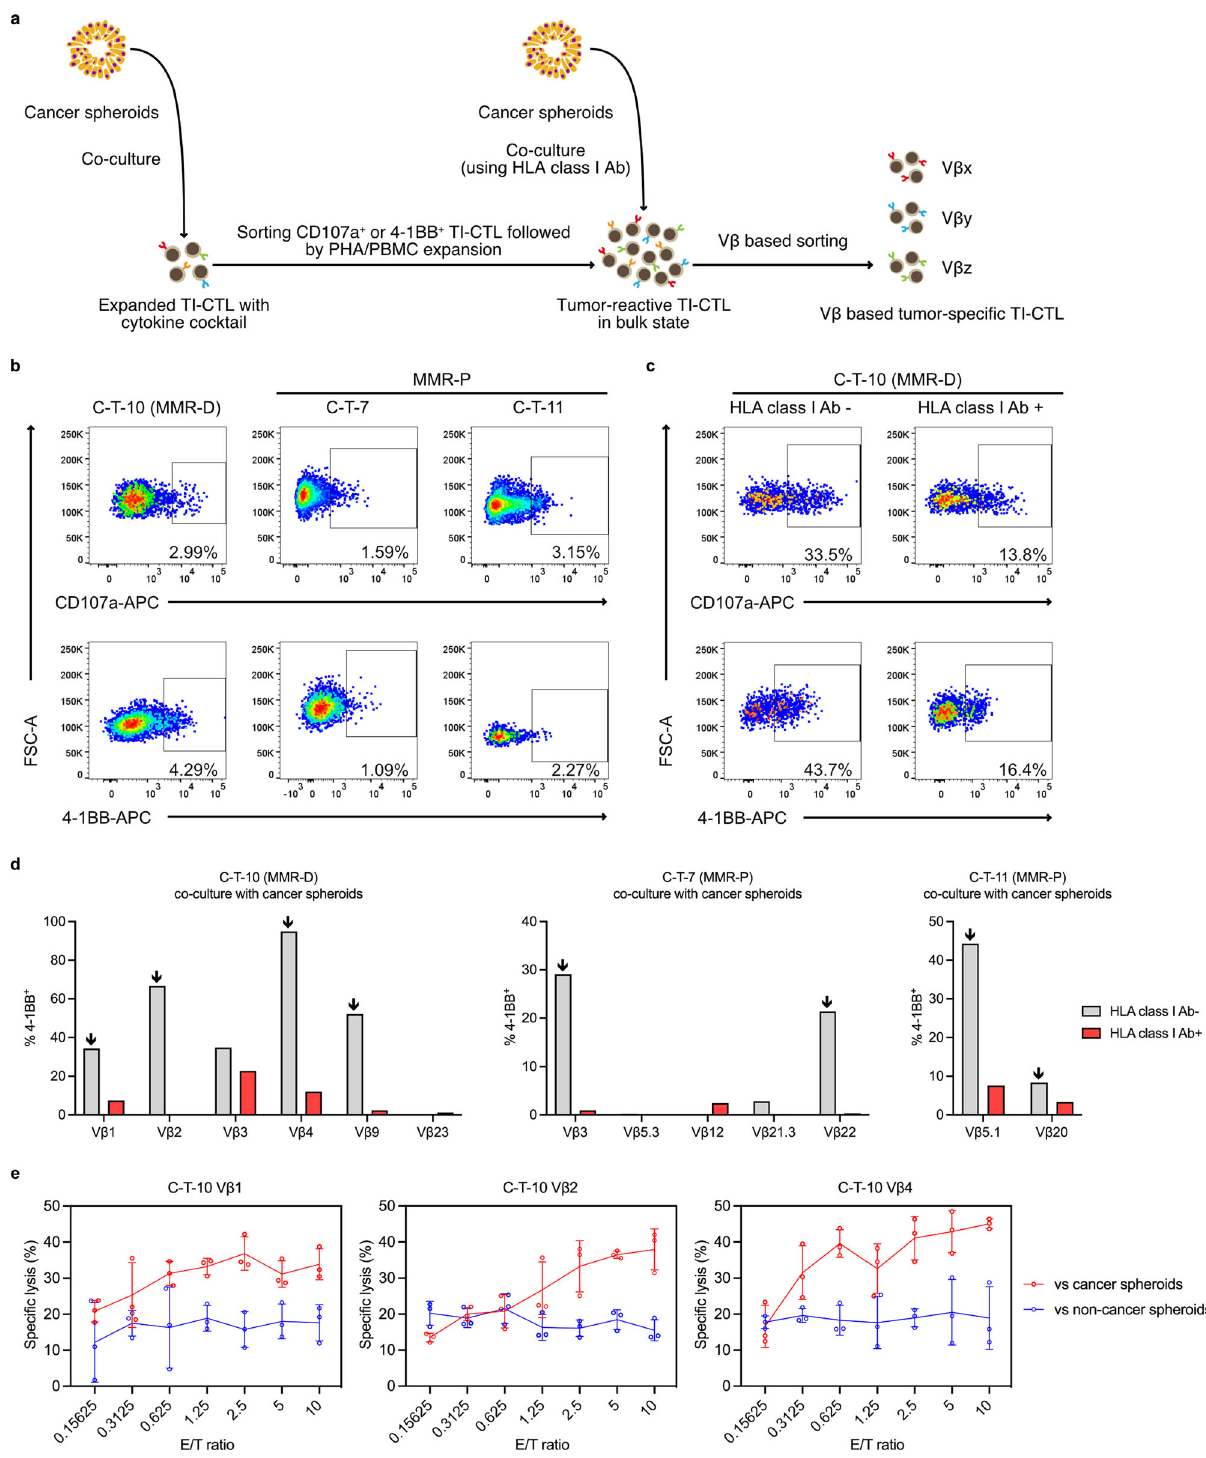
Fig. 2 Selection of tumor-speci fi c TI-CTL from cytokine-expanded populations. a Overview of the tumor-speci fi c TI-CTL selection from cytokine- expanded populations. b Cytokine-expanded TI-CTL were co-cultured with autologous cancer spheroids. CD107a + or 4-1BB + populations were sorted and selectively expanded by the PHA/PBMC method. All data were gated on CD45 + live cells. c Tumor-reactive TI-CTL were co-cultured with cancer spheroids again with or without HLA class I antibody. Representative data of three independent experiments are shown from C-T-10 MMR-D. All data were gated on CD45 + live cells. d Activation of tumor-reactive TI-CTL against cancer spheroids was evaluated on a per V β -subtype basis. HLA class Ι blocking antibody was used for the prediction of TCR-HLA class Ι axis dependency for the TI-CTL activation. The arrows designate V β subtypes that mainly depend on TCR-HLA class Ι interactions for their activation. Left: data from MMR-D. Representative data of two independent experiments are shown. Middle and right: data from MMR-P. Representative data of three independent experiments for each are shown. e Killing function data of the selected V β -based TI-CTL subgroups against autologous spheroids. Representative data of three independent experiments are shown. The 51 Cr release assay was applied for the quanti fi cation. Dots represent individual values. Means are connected by lines; error bars represent SD. n = 3 per point. COMMUNICATIONS BIOLOGY|